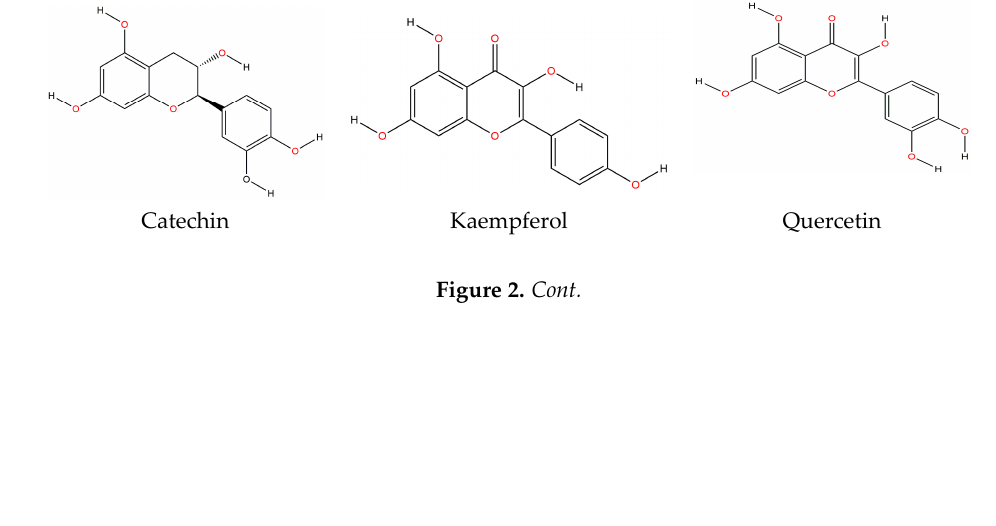
Figure 2. Structures of major flavonoids of P. vulgaris [46].